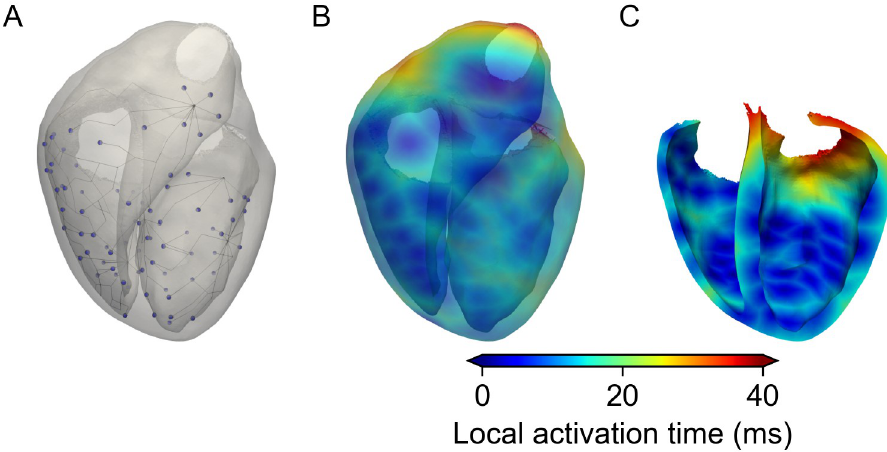
Fig 7. Optimized activation sequence and local activation times. A: Resulting optimized Purkinje tree used to generate activation times within the ventricles. B: Local activation times throughout the ventricles. C: Cut view of the ventricles showing the initial activation at the septum. Due to the small size of the ventricles and the high velocity within the Purkinje network of 3655mm/s, all stimulation points activate roughly synchronously.